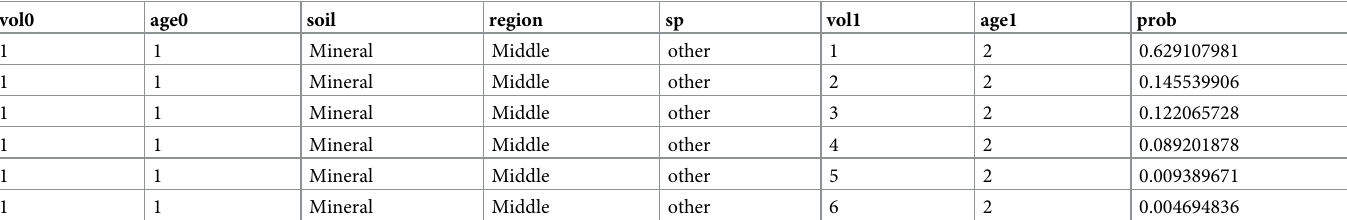
Table 1. Example of transition probabilities (prob) for a forest at Mineral soil in the Middle Boreal vegetation zone with ‘other’ as a dominant tree species in respect to dynamic variables vol and age where index ‘0’ refers to the initial state and ‘1’ to the new states after one simulation step.